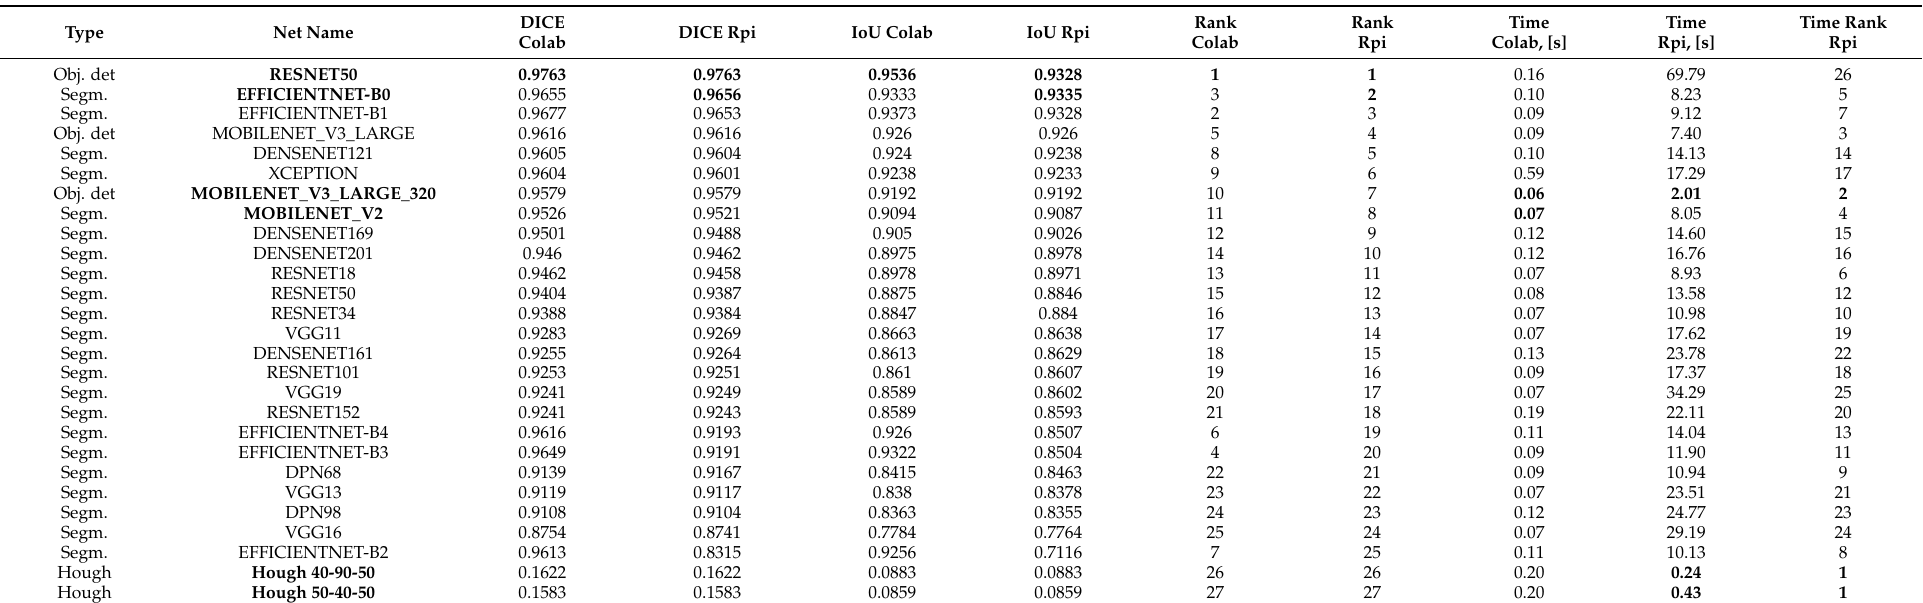
Table 7. Test results tested on Google Colab and Rasperry Pi (RPi) using bounding boxes around semantic segmentation, Hough transform predictions and ground truth masks. The Hough transform and the two best algorithms based on DICE, IoU and time for object detection and segmentation are in bold and were chosen for implementation in the educational